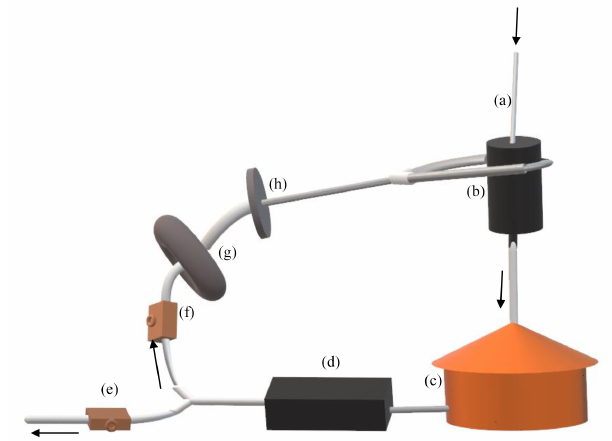
Figure 1. Illustration of the dilution unit behind the heated total in- let. (a) An inlet tube attached to the total inlet, (b) diluter, (c) multi MINI impactor, (d) pump, (e) valve to control outflow, (f) valve to control air going back in the system, (g) pre-filter (Whatman, Sigma-Aldrich), and (h) main filter (Millipore, Sigma-Aldrich). Ar- rows indicate the air flow